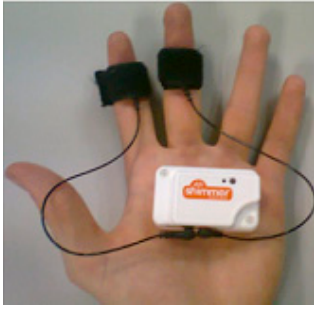
Figure 3. Position of the electrodes of the Shimmer galvanic skin response (GSR) sensor.